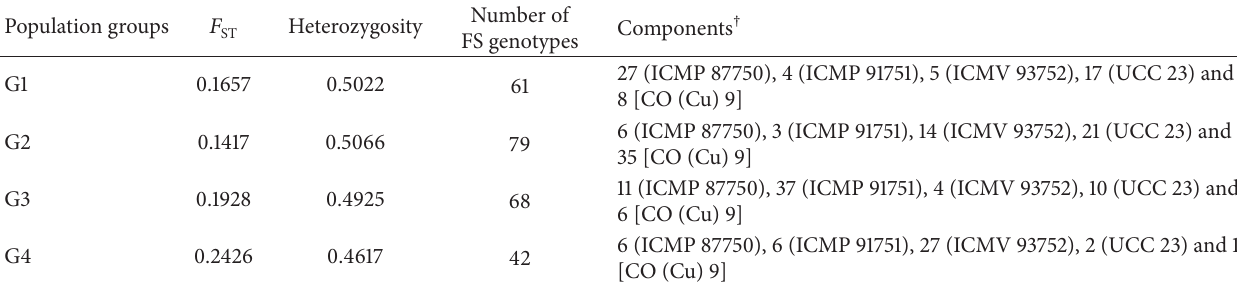
Table 3: Significant divergence between groups (subpopulations) and average distances (expected heterozygosity) between FS progenies in the same